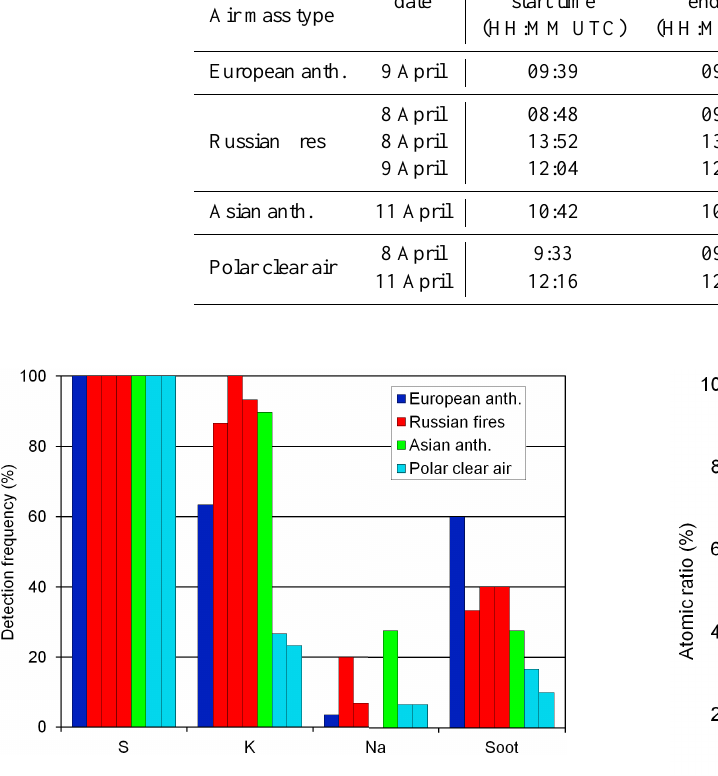
Fig. 14a. Detection frequency of the major elements (EDX) and soot (visual identification) among individual submicron aerosol par- ticles.